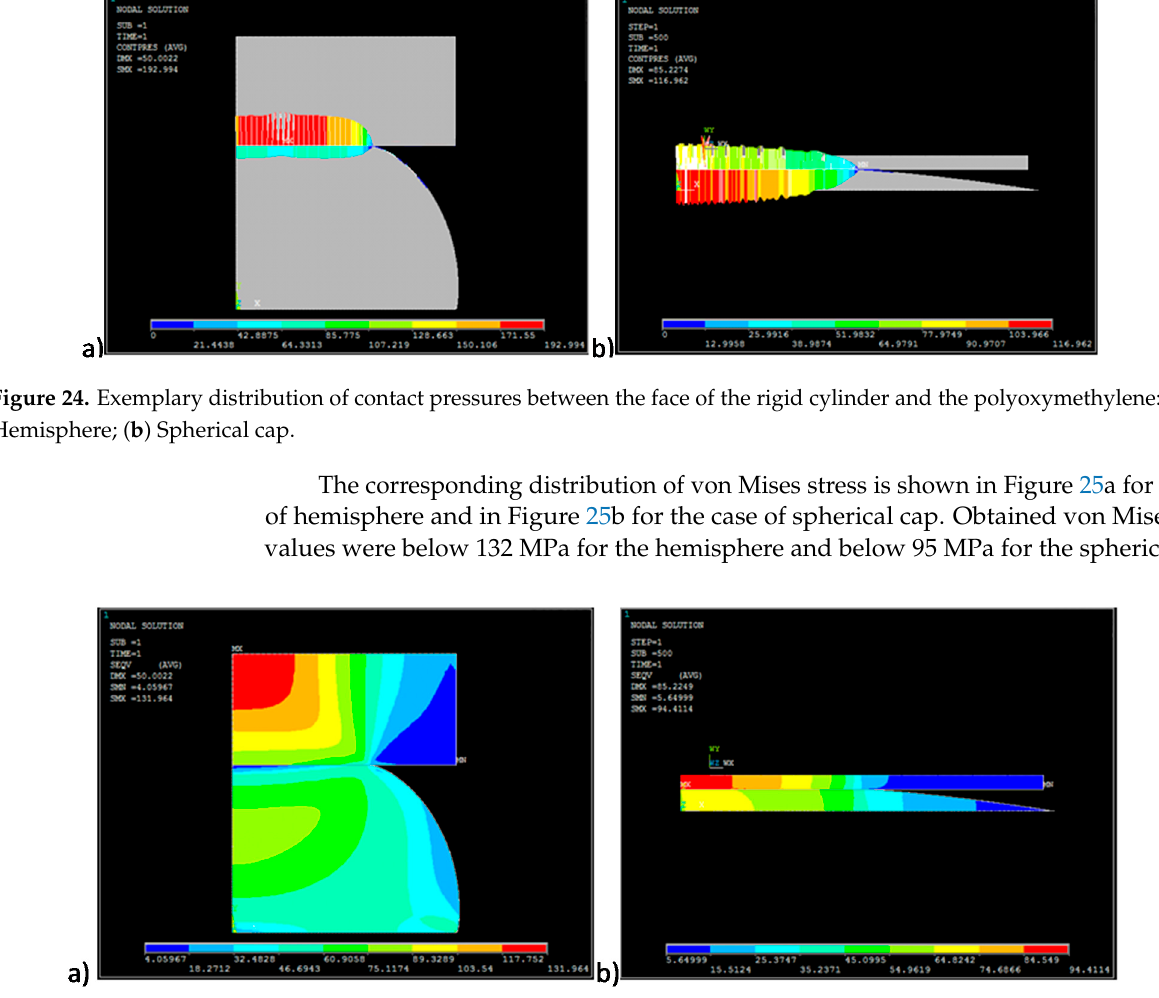
Figure 26. Exemplary distribution displacements in the horizontal direction for the contact between the face of the rigid cylinder and the PTFE: ( a ) Hemisphere; ( b ) Spherical cap.